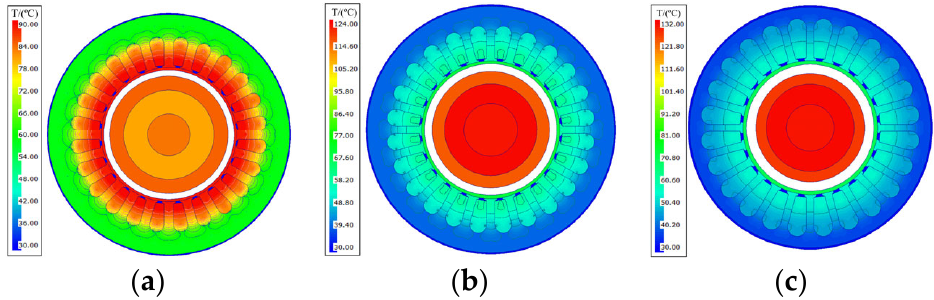
Figure 26. The temperature distribution under the three cases at rated speed: ( a ) Case 1; ( b ) Case 2; ( c ) Case 3.